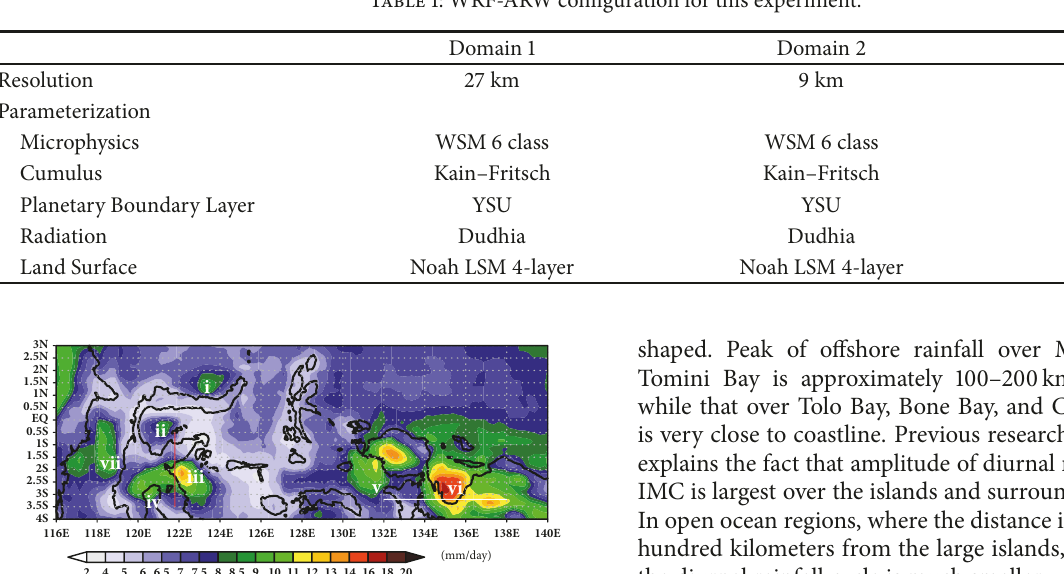
Table 1: WRF-ARW configuration for this experiment.